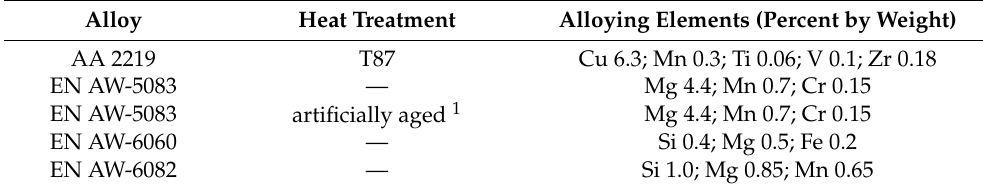
Table 1. Materials investigated based on µ CT within the preliminary